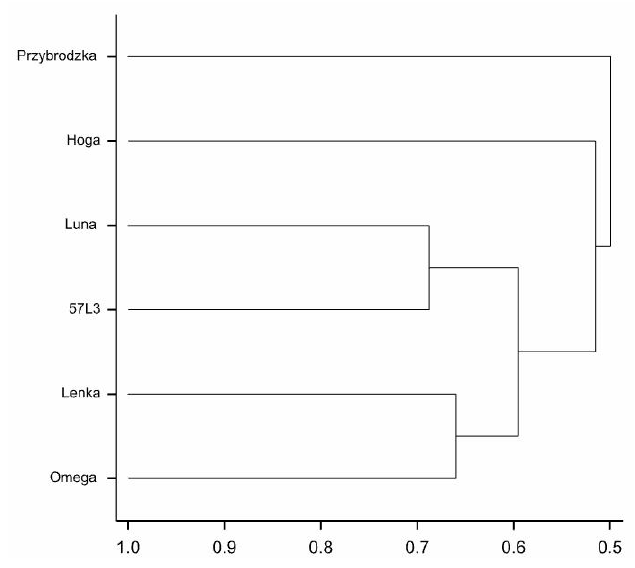
Figure 1. A dendrogram of Camelina sativa genotypes. The cultivars were grouped hierarchically using the unweighted pair group method of arithmetic means (UPGMA).